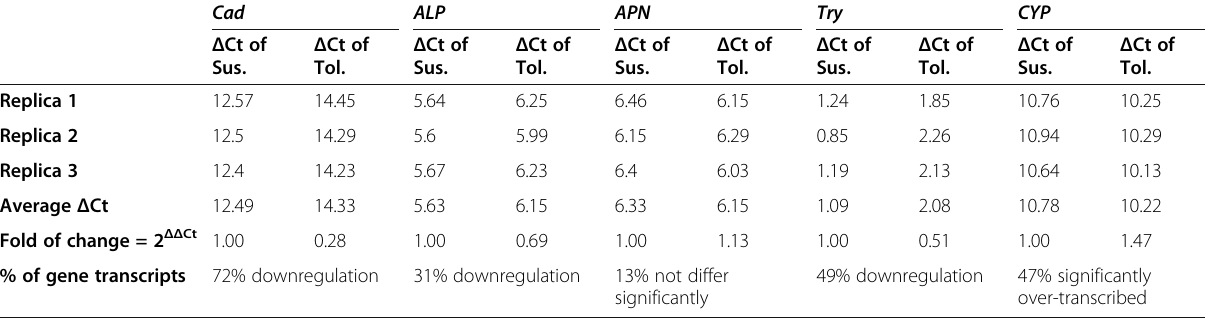
Table 5 qPCR analysis: Relative fold change expression of Cad (cadherin), ALP (alkaline phosphatase), APN (aminopeptidase N), Try (trypsin), and CYP (cytochrome P450) in midgut of susceptible (Sus.), and Bt Cry1C tolerant (Tol.) strain of S. littoralis